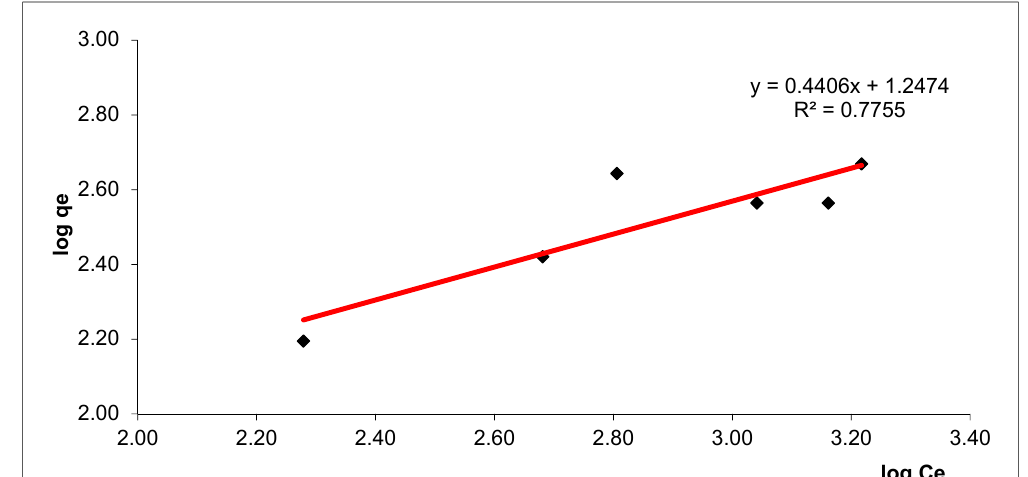
Figure 5. Freundlich adsorption isotherm.